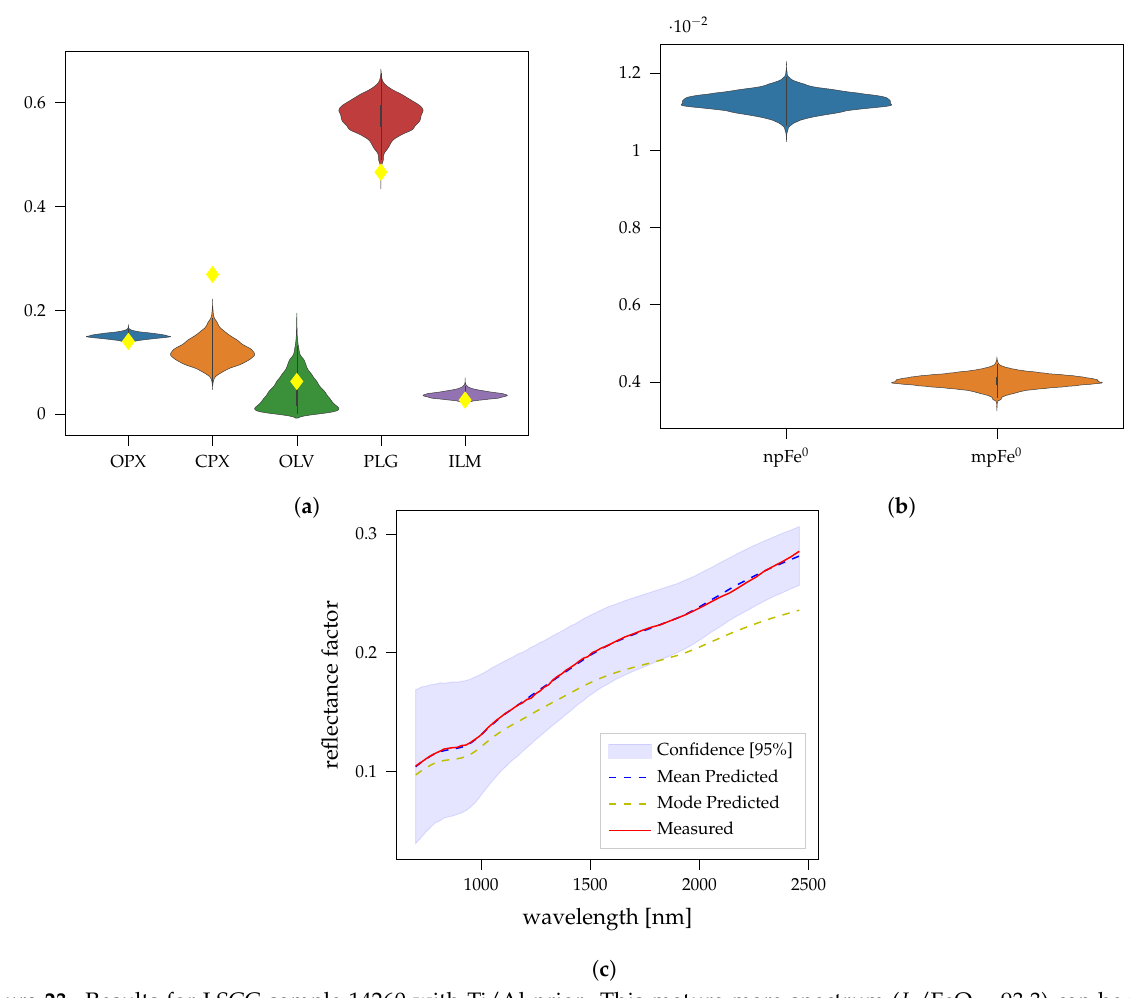
Figure 23. Results for LSCC sample 14260 with Ti/Al prior. This mature mare spectrum ( I s /FeO = 93.3) can be well characterized. Yellow diamonds mark the estimated theoretical mineral fractional abundances. Except for a small difference in theoretical and predicted clinopyroxene abundance, the fit is good. ( a ) Endmember abundances (14260); ( b ) smFe abundances (14260); ( c ) Confidence plot